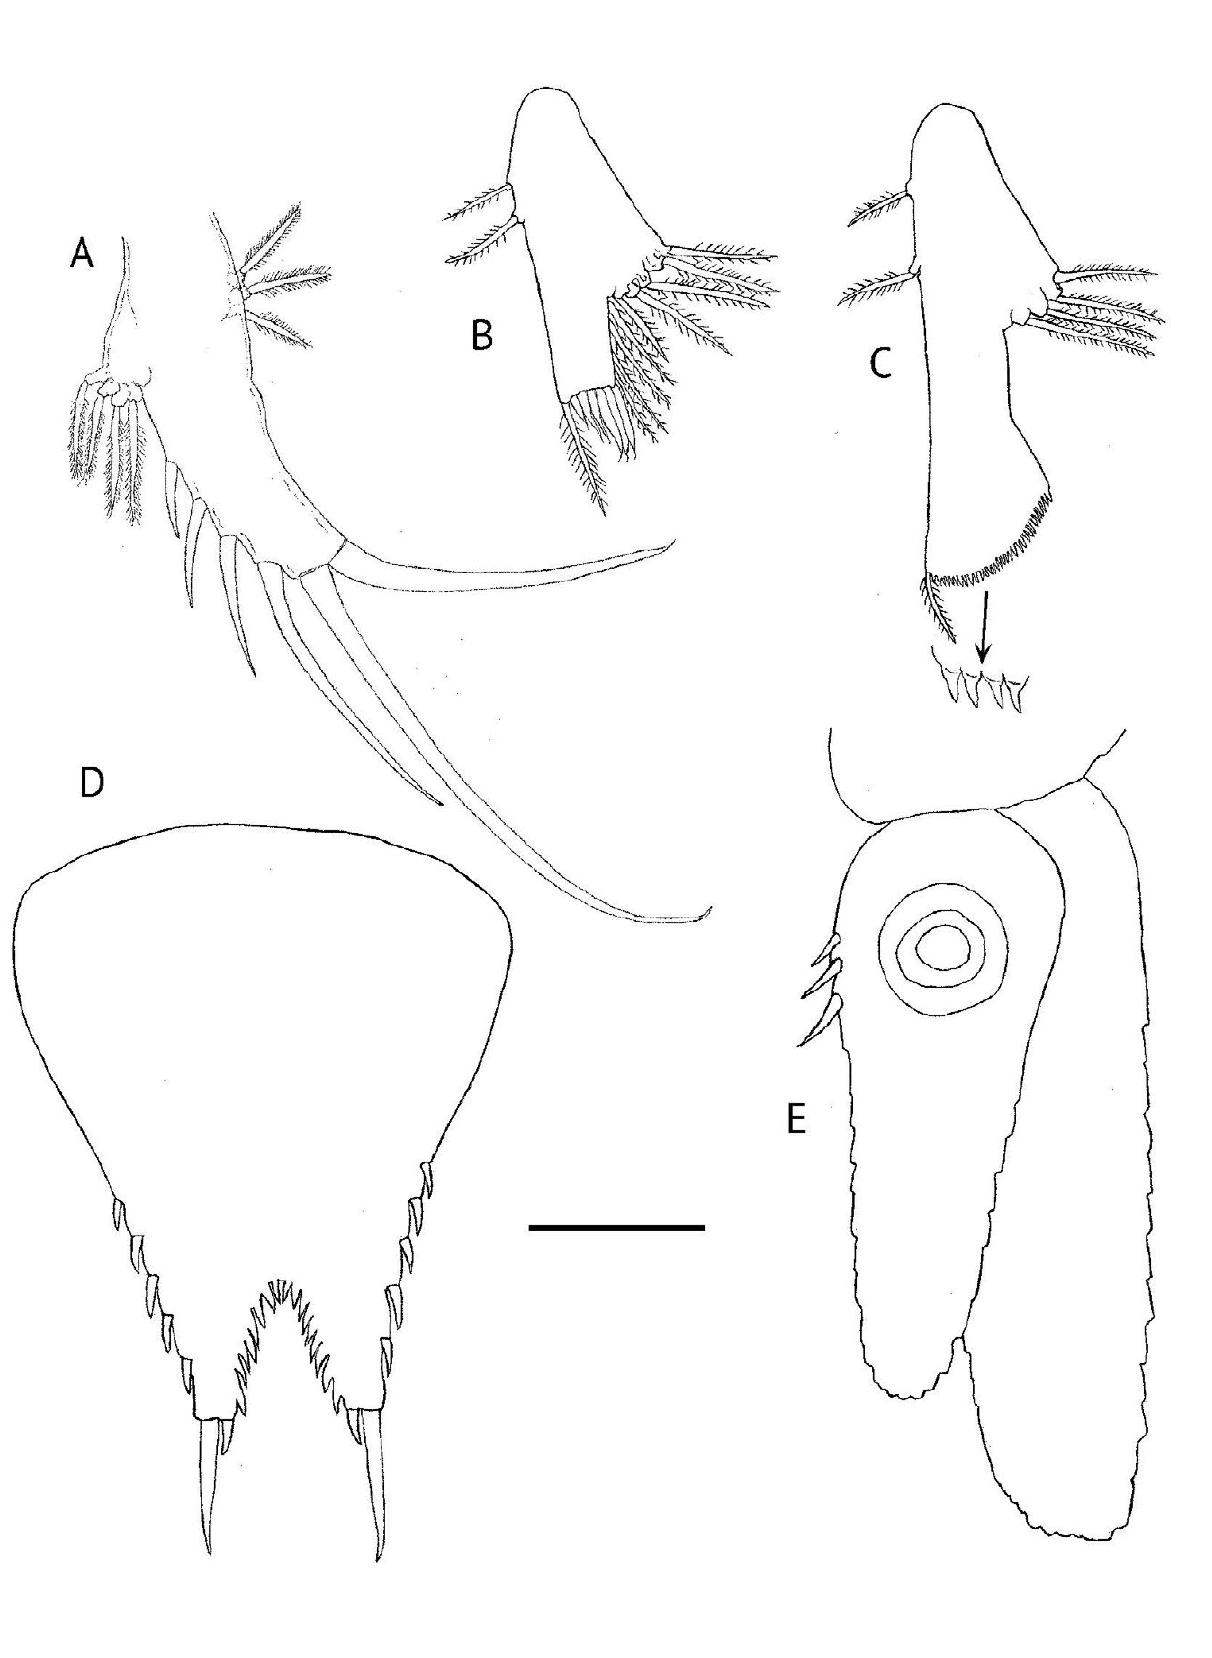
Figure 4. Heteromysis ( Olivemysis ) cocoensis n. sp. adult male, 3.0. mm. A. Pleopod 1, posterior view. B. Pleopod 3, posterior view. C. Pleopod 4, posterior view, with enlargement of distal setae. D. Telson. E. Uropod. Scale: A, 0.25 mm; B–E, 0.1